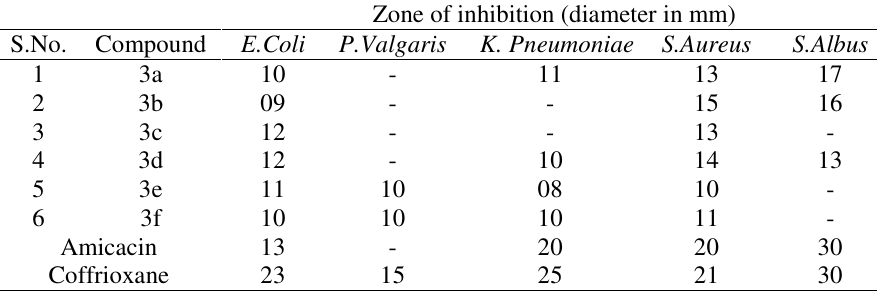
Table 2. Antibacterial activity of synthesized